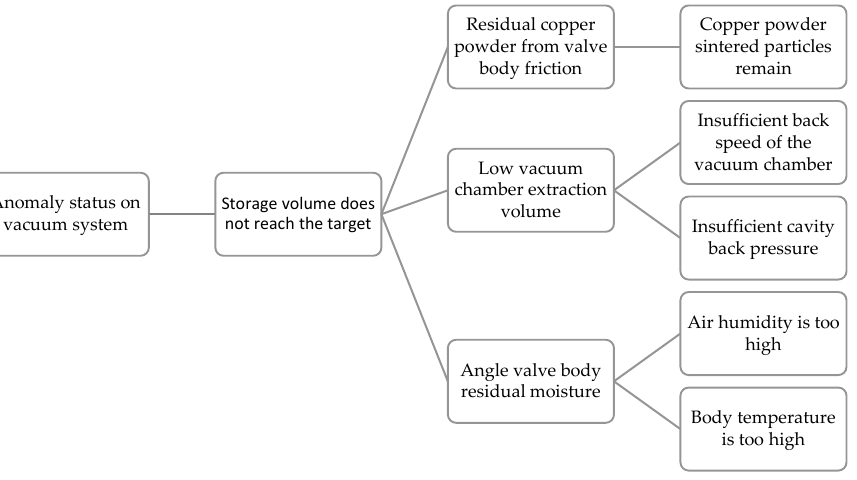
Figure 5. The root cause identification using the Five Whys tool.